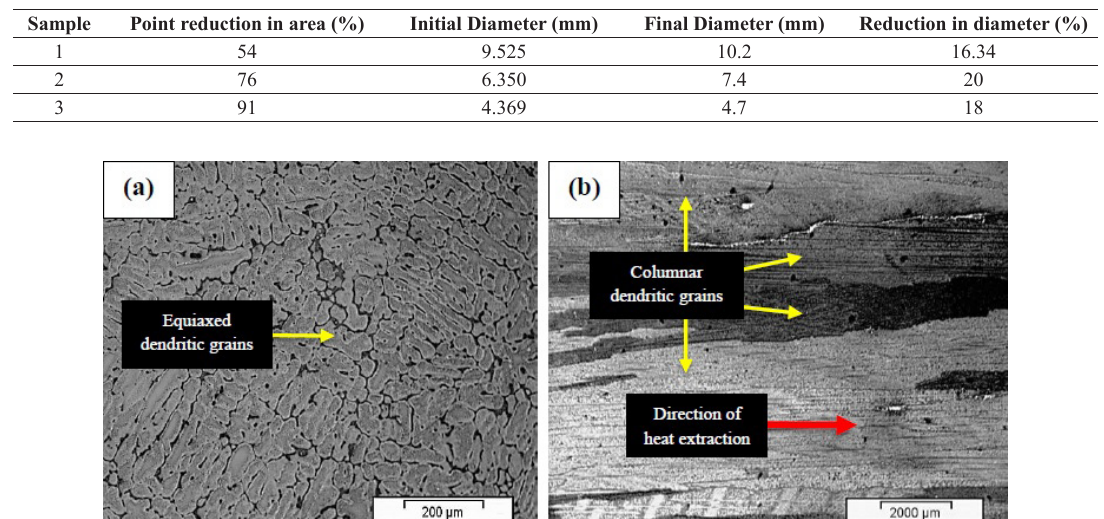
Figure 2. Original macrostructures of the samples solidified (a) Conventionally (b)